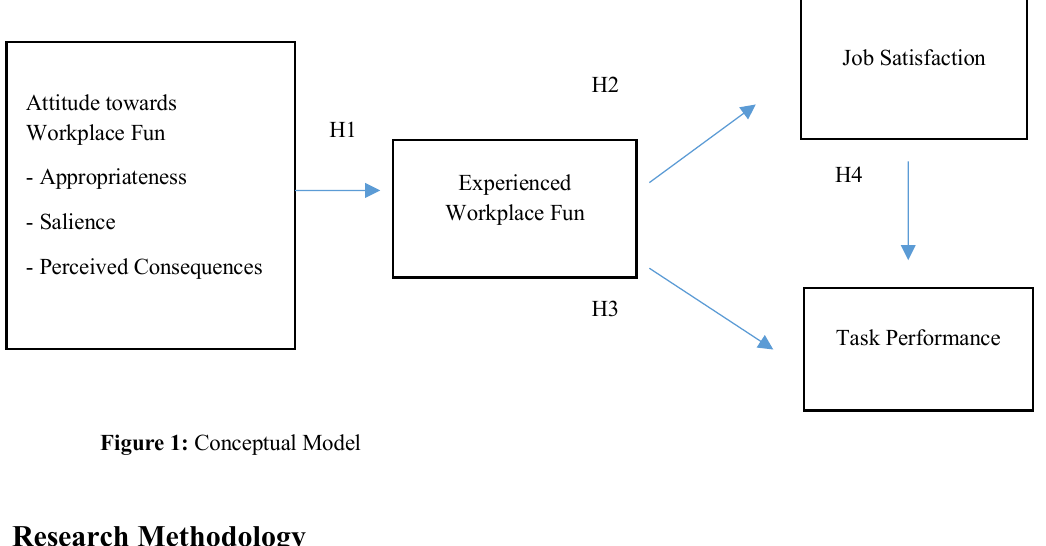
Figure 1: Conceptual